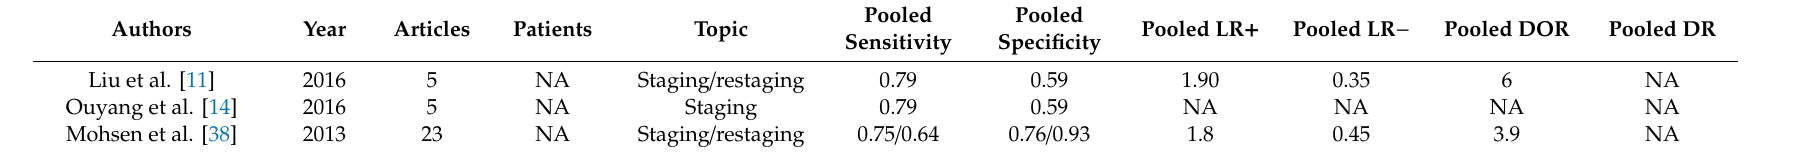
Table 4. Meta-analyses on radiolabeled acetate PET / CT in prostate cancer.